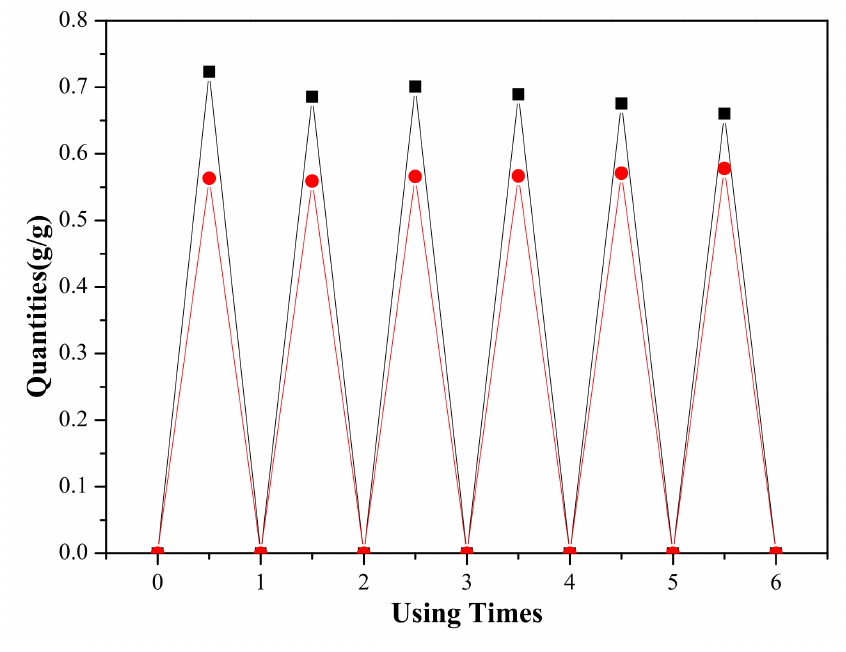
Figure 11. NO 2 absorption quantities ( ) and desorption quantities ( ) in ([EMIM] [TFA] + TEA) over six adsorption–desorption